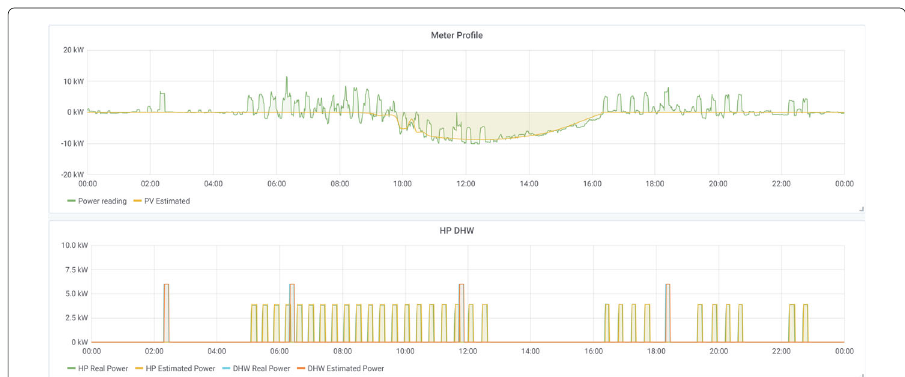
Fig. 6 NILM on HP_06 and DHW_06, on